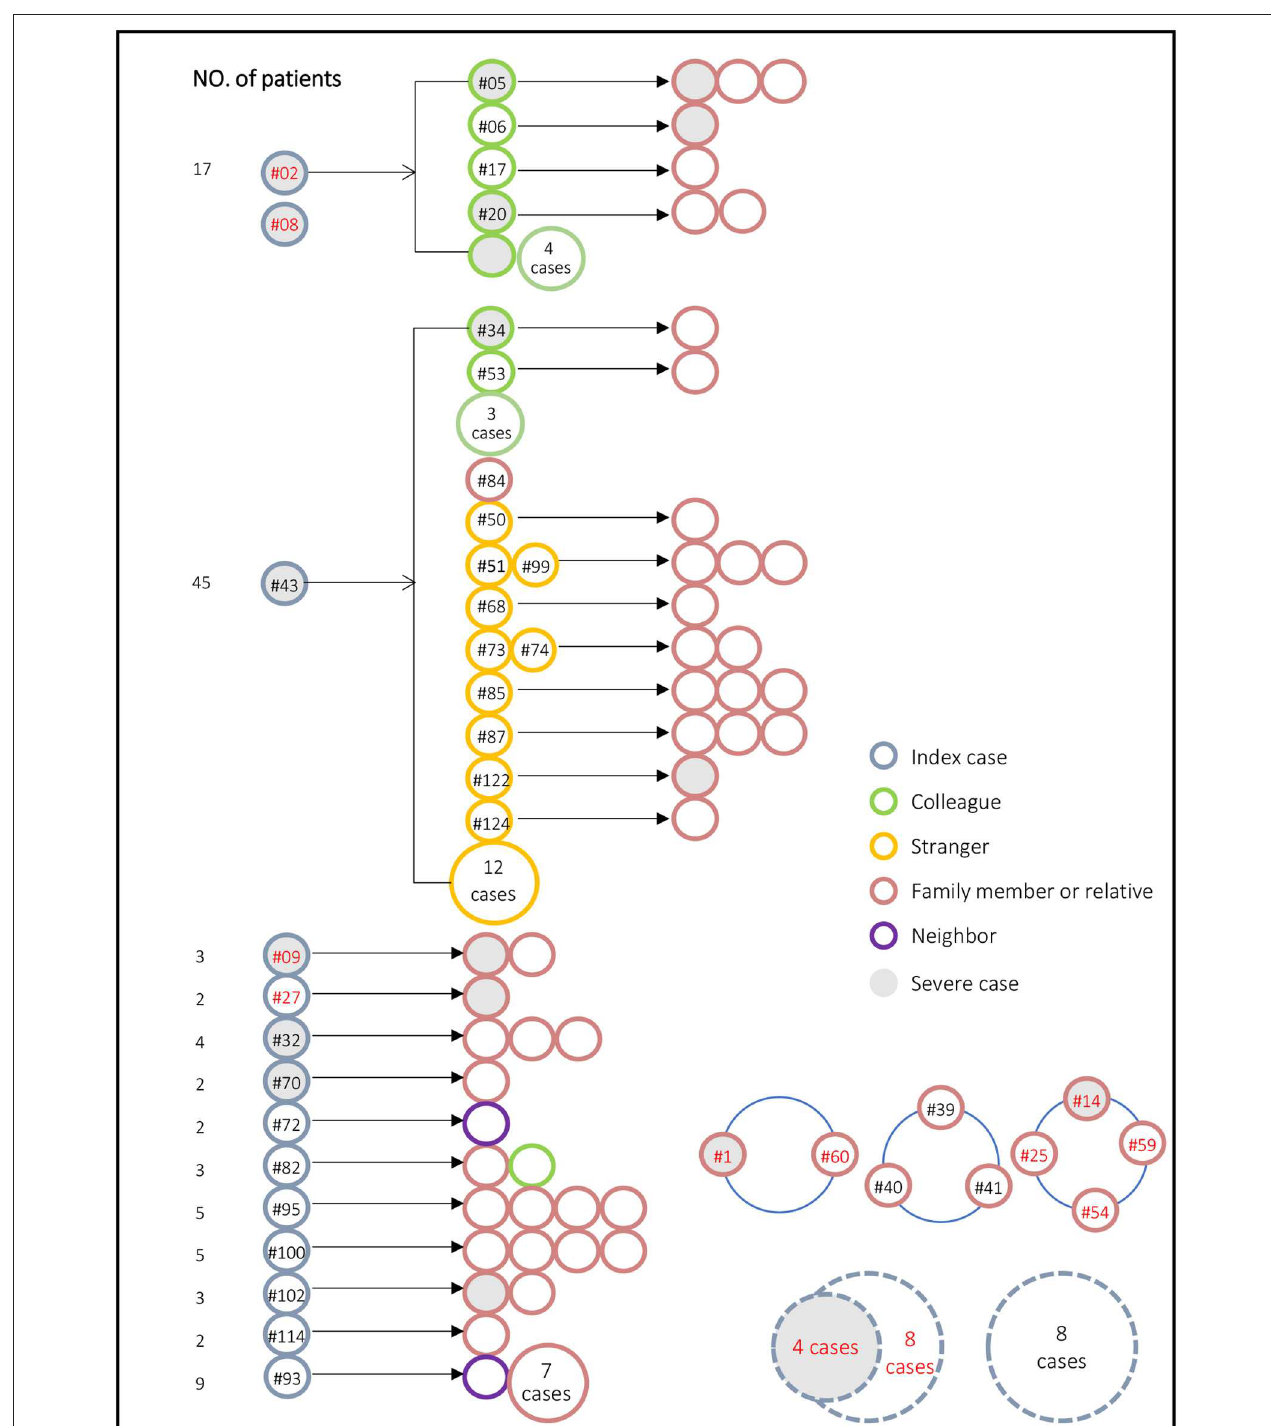
FIGURE 3 | Transmission chain for the 131 confirmed COVID-19 cases in Tianjin. Red figures indicate a Wuhan-related exposure. Gray solid fill represents severe case. Numbers in dashed circle (lower right corner) represent the total number of unrelated independent events, and these patients did not transmit the virus to others. The blue hollow ring in the lower right corner indicates that these patients were infected at the same time or from the same source, for example, #14, #25, #54, and #59 traveled to Wuhan together.